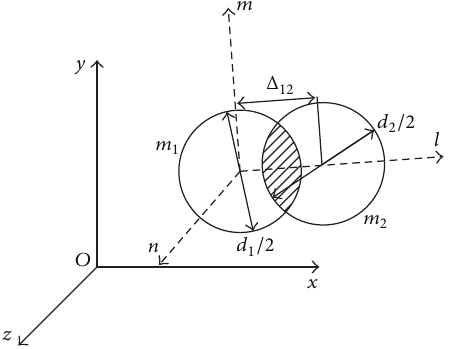
Figure 2: Coordinates of collision for adjacent